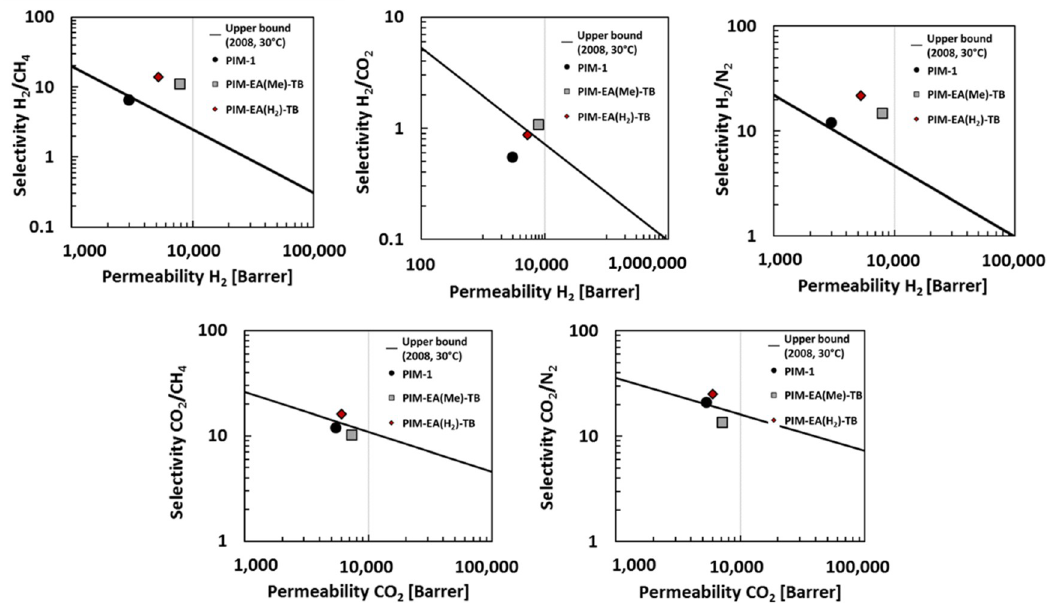
Figure 4. Robeson plots for H 2 /CH 4 , H 2 /N 2 , H 2 /CO 2 , CO 2 /CH 4 and CO 2 /N 2 for PIM-1 [8] ( ), PIM- EA(Me 2 )-TB [16] ( ) and PIM-EA(H 2 )-TB [our study] ( ) at 30 °C and 1 bar. The lines represents the 2008 upper bound for each gas pair [21].